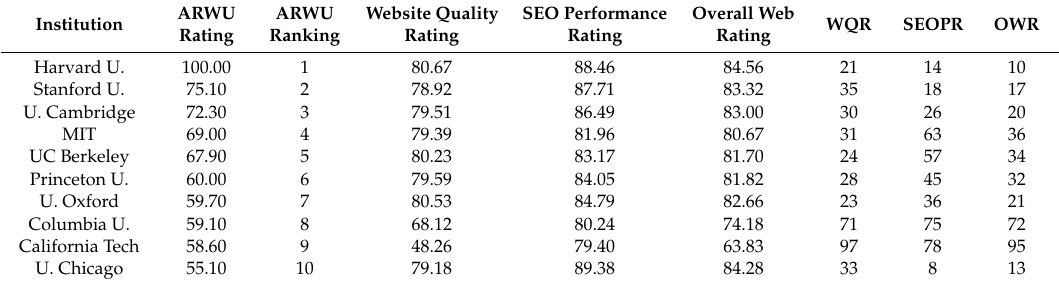
Table 8. Data formation.